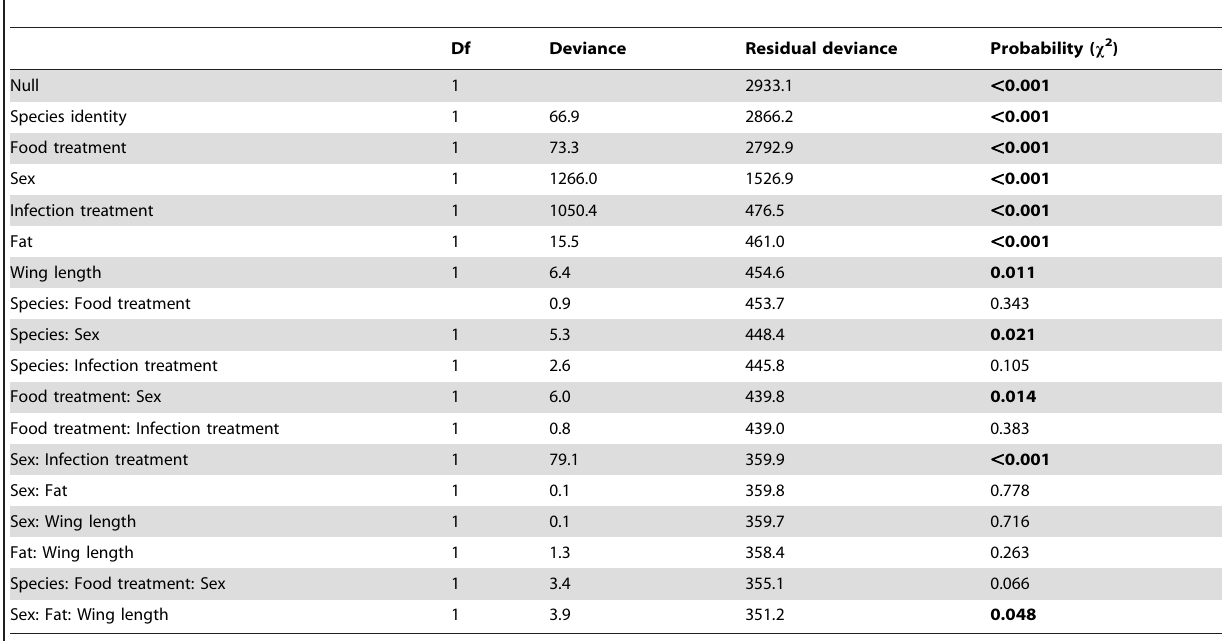
Table 6. Analysis of deviance of expected gregarine abundance according to species identity, food treatment (fed and starved), sex, infection treatment (parasite-treated and parasite-control), thoracic fat content and wing